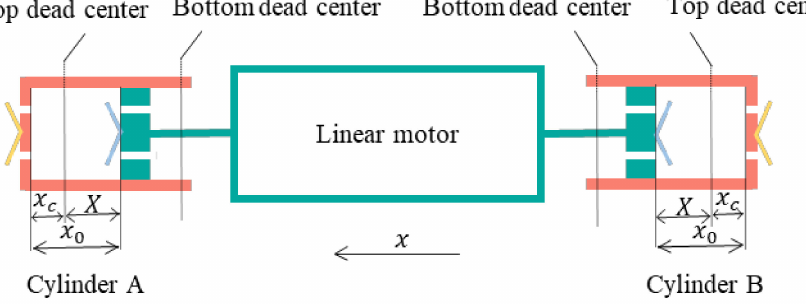
Figure 4. The cylinder of a